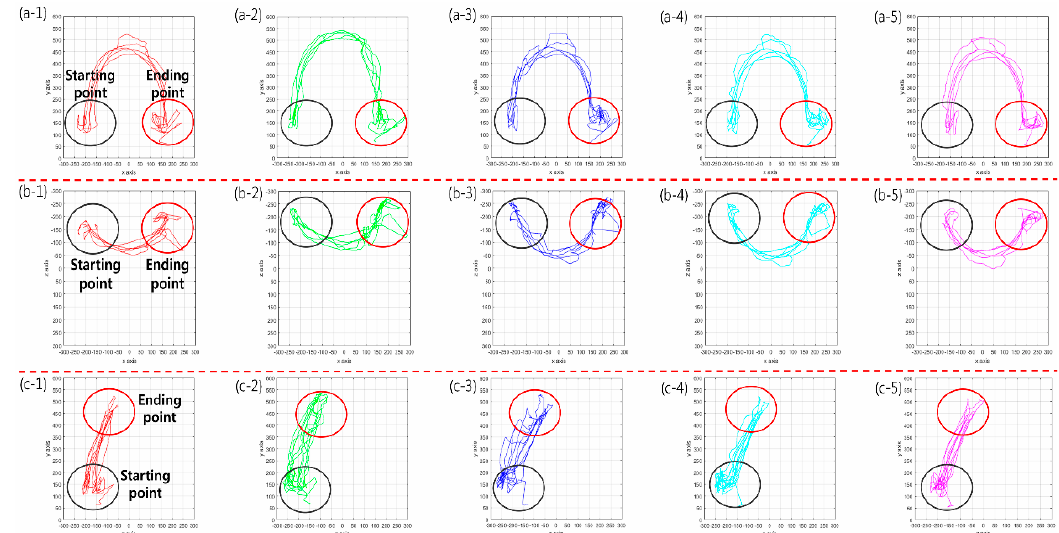
Figure 4. 2D movement pattern using 3D coordinates (3-axis). ( a )/( 1 – 5 ) X–Y axis, ( b )/( 1 – 5 ) X–Z axis; ( c )/( 1 – 5 ) Z–Y axis. Red line: thumb (finger); green line: index; dark blue line: middle; sky blue line: ring; purple line: pinky. The start and endpoints can be displayed to determine the exact start and endpoints and the user can analyze wrist motion and depth using the 3D graph.